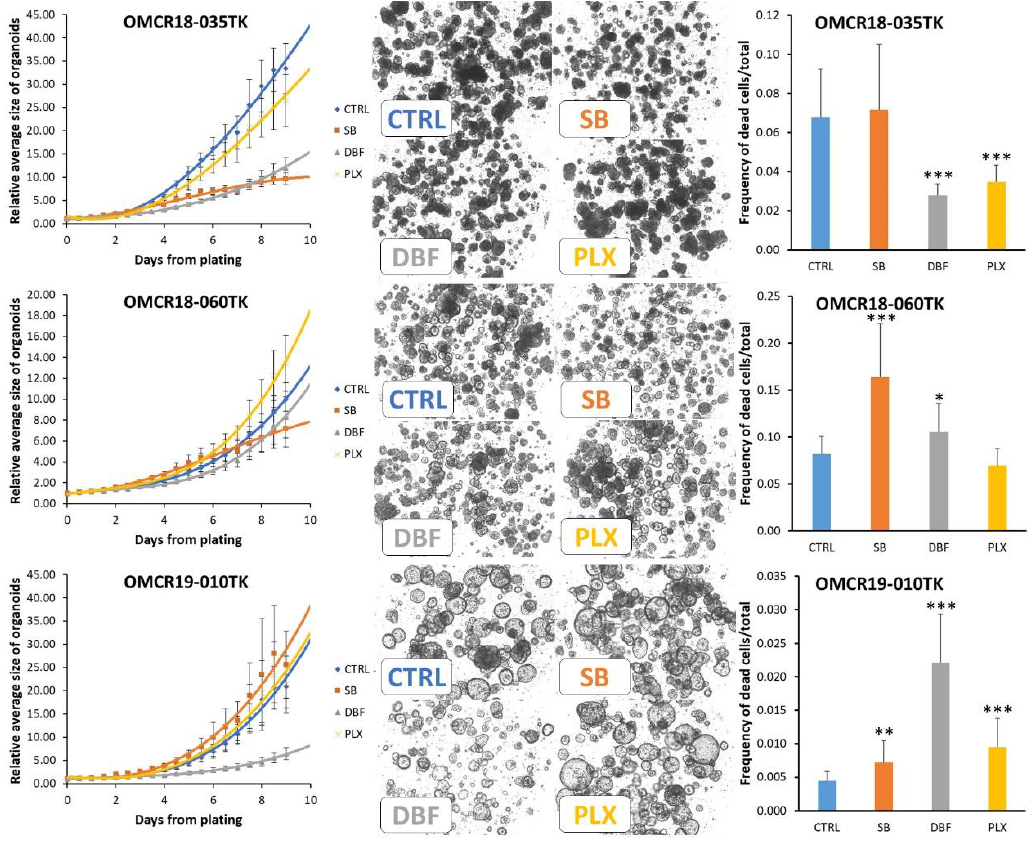
Figure 5. Organoids with wild-type EGFR signaling; modulation of growth by SB202190 (10µM), Dabrafenib (1µM) and PLX8394 (1µM). Left column: interpolation of the growth curves live-monitored for 9 days (12 h steps); all data are normalized against point 0 values to reduce variations in plating efficiency among different organoids. Each experimental point represents the mean of 4 – 5 replicates (geltrex domes) in three tests. Mutations: OMCR18-035TK (frame-shift mutation of TP53 with undefined effect); OMCR18-060TK (no mutation in our NGS panel); and OMCR19-010TK (double PTEN truncation, undescribed ALK mutation, TP53 R181H). The statistics of each experimental point vs. controls (CTRL) are detailed in TabS3. Center column: example images from the last experimental point; the organoids monitored in a single geltrex dome are shown. Right column: the cytotoxic effects of drugs were assessed using live fluorescent marking and normalized against total cells (in the same tests shown in the left column). Statistics vs. controls (CTRL): * p ≤ 0.05; ** p ≤ 0.01; *** p ≤